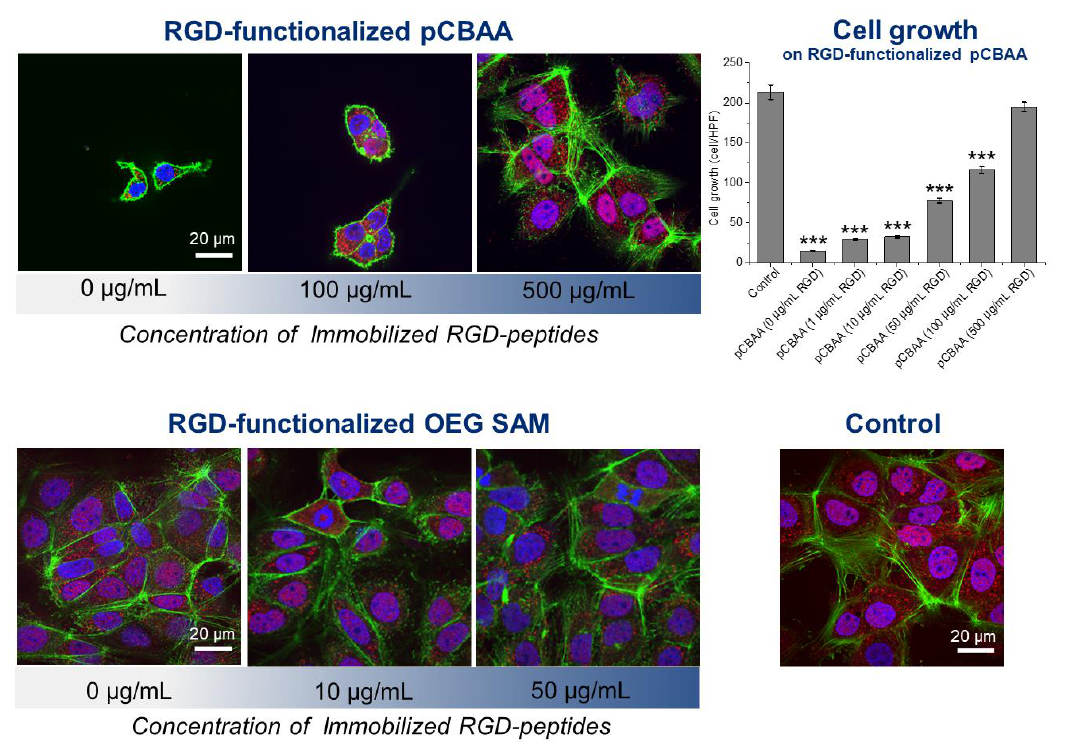
Figure 2. Growth of Huh7 cells on RGD-functionalized coatings. Examples of spinning disk confocal microscopy images of coatings functionalized by solutions of di ff erent concentrations of RGD peptides. Staining: Yes-associated protein (YAP) (red), F-actin (green), and nucleus (blue). Upper line: RGD-functionalized poly(carboxybetaine acrylamide) (pCBAA) functionalized using the method A-1 in Figure 1 (0, 100, and 500 µ g / mL of the RGD peptides in the solution were used for functionalization) and plot of the dependency of the cell growth (number of cells per high-power field) on the RGD peptide concentrations. One-way analysis of variance with the Newman-Keuls test was performed, and data are expressed as means ± SEM, *** p < 0.001. Bottom line: RGD-functionalized OEG SAMs functionalized using the method A-2 in Figure 1 (0, 10, and 50 µ g / mL of the RGD peptides in the solution were used for functionalization; no dependency was found) and the control (cells seeded onto standard 35-mm Petri dishes).